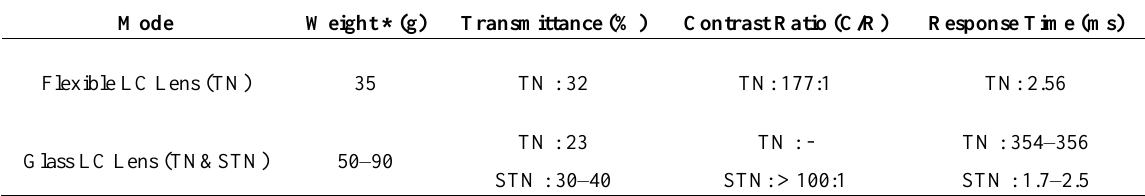
Table 1. Comparison the flexible liquid crystal lens (TN mode) and the commercial glass liquid crystal lens (TN and STN mode) for the active shutter glasses.